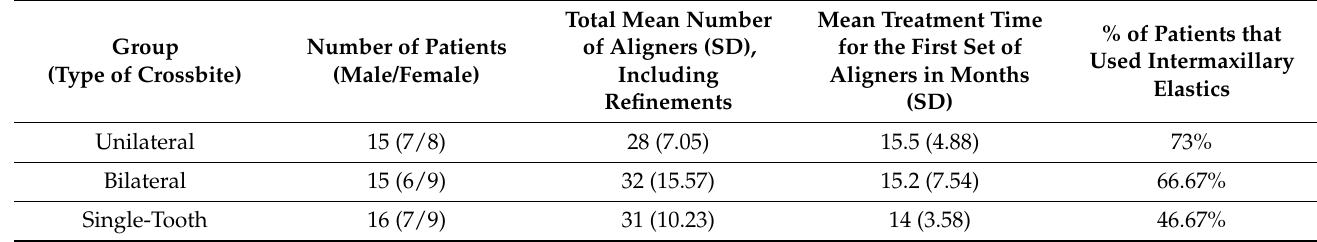
Table 1. Characteristics of the sample. SD: standard deviation, %: